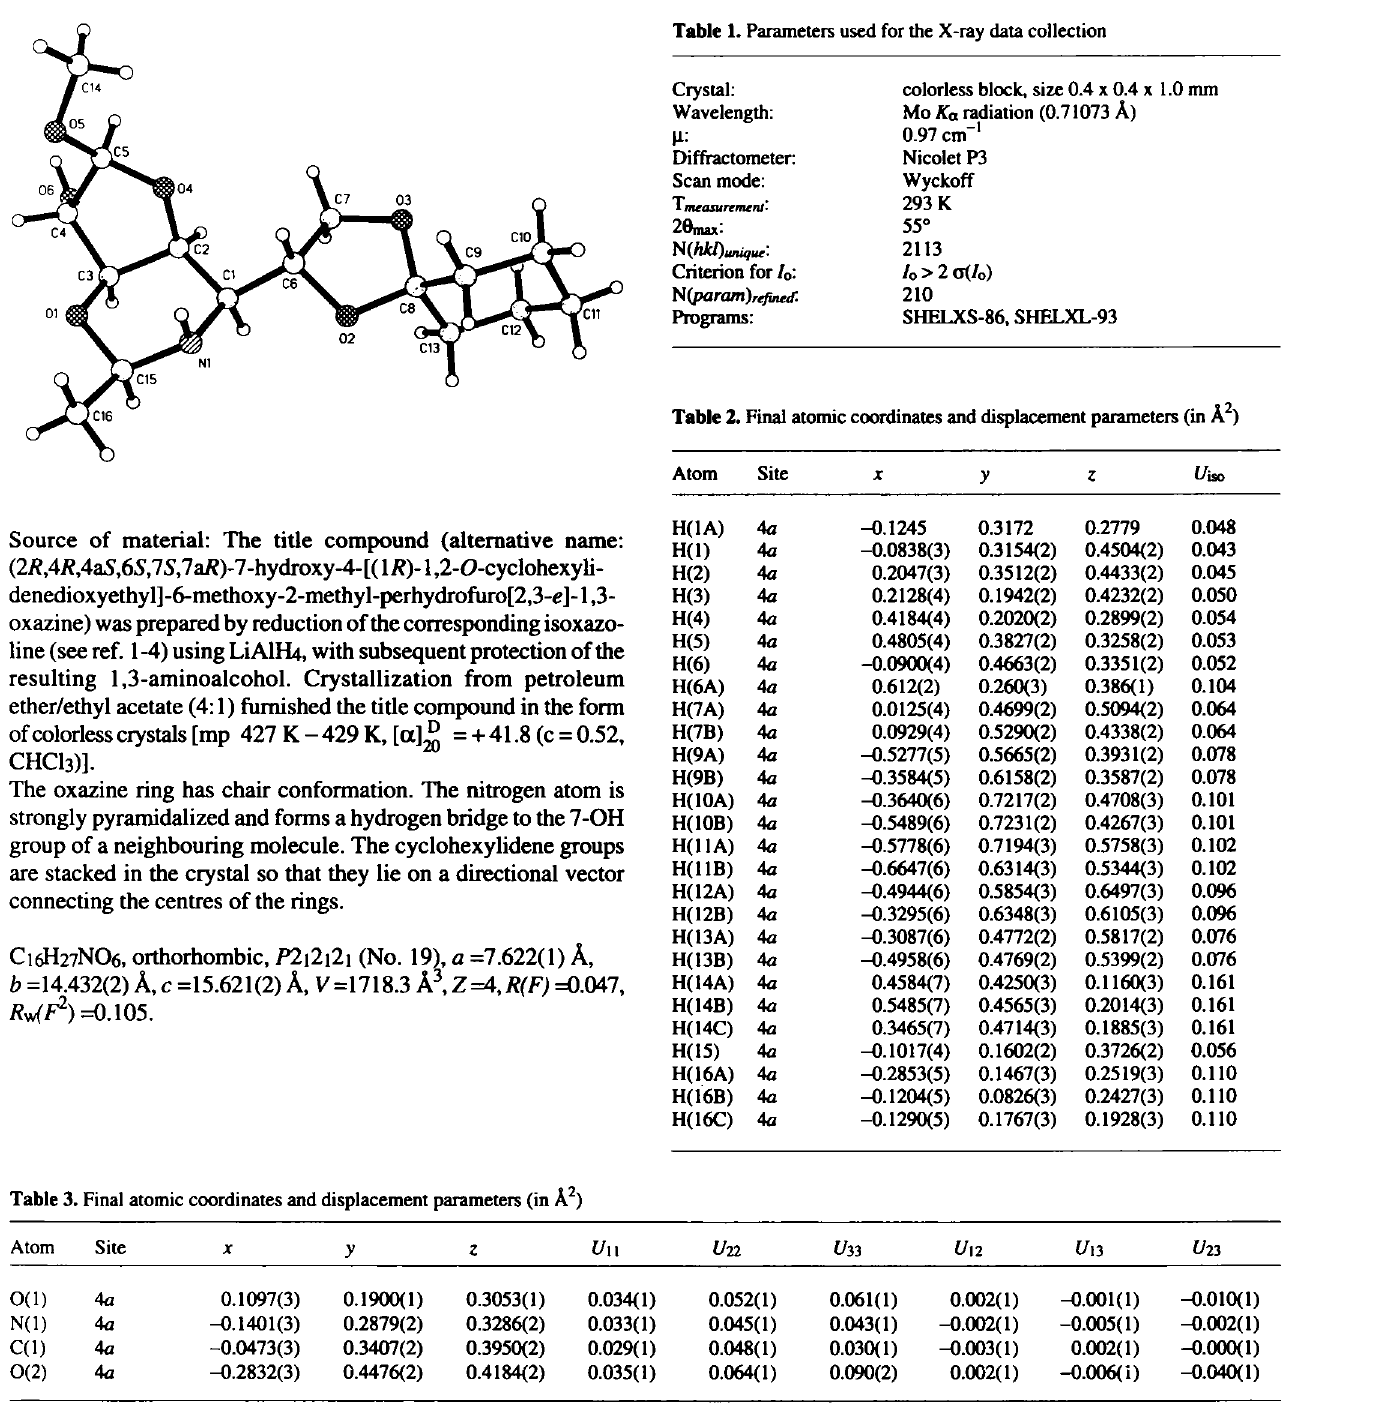
Table 1. Parameters used for the X-ray data collection